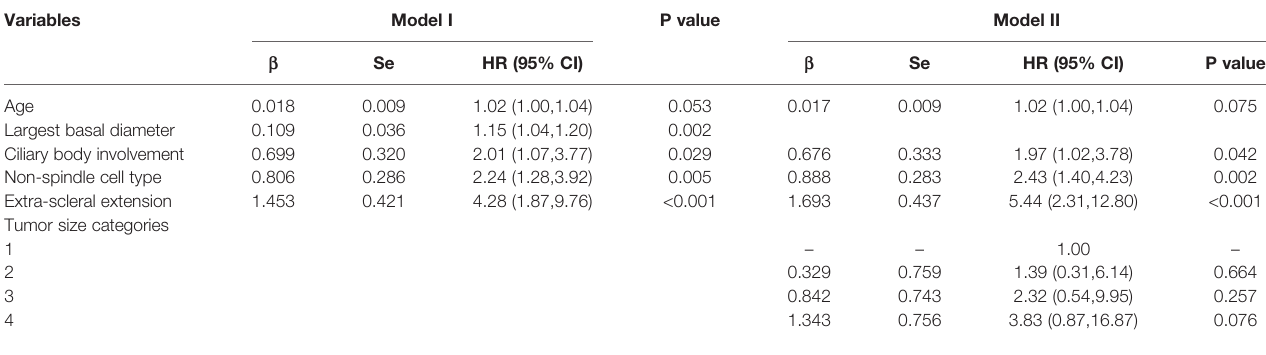
TABLE 2 | Cox multivariate regression analysis of the prediction model in the training cohort.